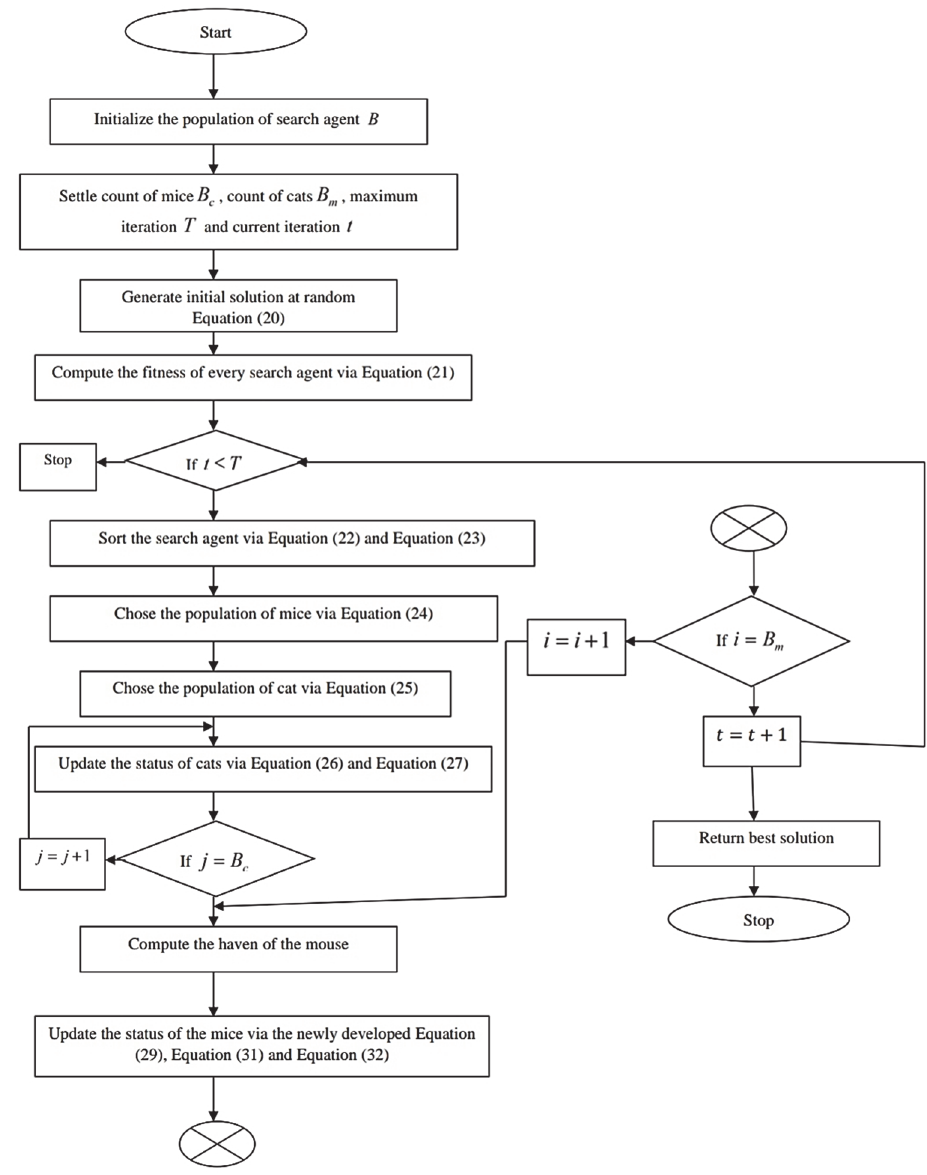
Figure 2. Flowchart of suggested SU-CMO.